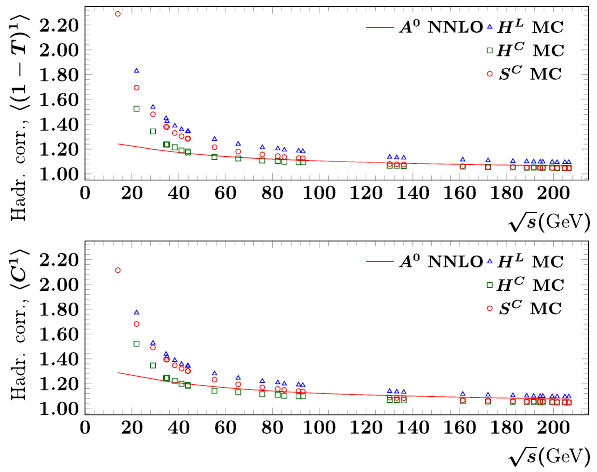
Fig. 2 Hadronization corrections extracted from MC generated sam- ples after extrapolation to Q 0 = 0GeV and the hadronization correc- tions from the A 0 scheme calculated as ratios of the hadron and parton levelpredictionsusing α S ( M Z ) = 0 . 118, α 0 (μ I ) = 0 . 5and M = 1 . 49. The hadronization corrections from the A T - and cusp-schemes are not shown, but these very closely follow the hadronization corrections from the A 0